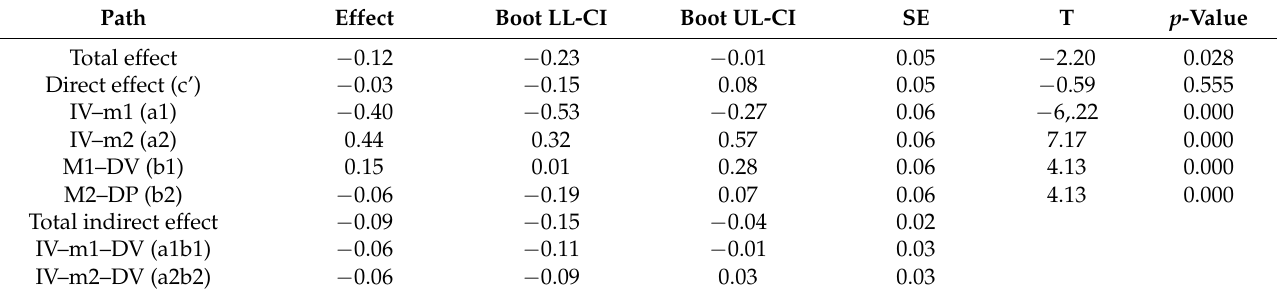
Table 2. Path coefficients for parallel mediation